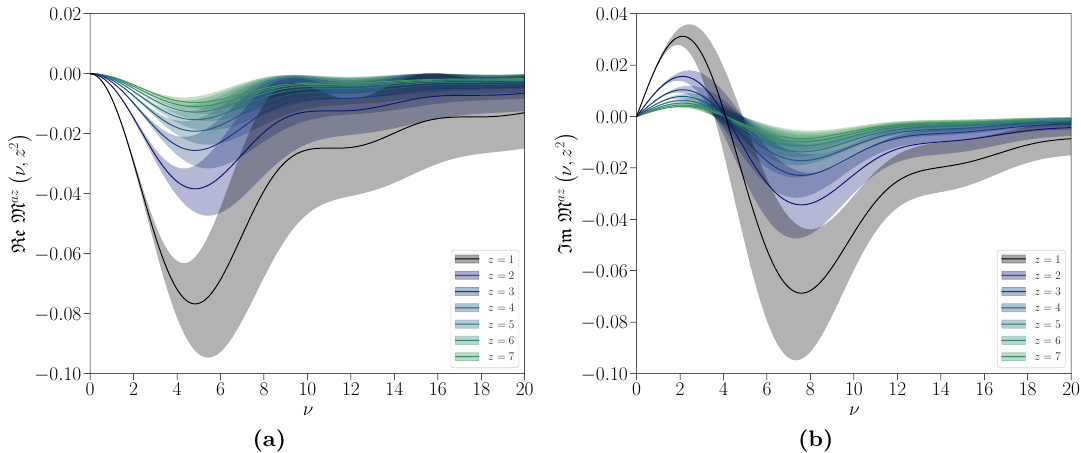
Figure 24. Visualization of the discretization effects determined by the optimal Jacobi polynomial fits { n = { 4 , 1 , 3 , 2 } and { n = { 3 , 3 , 1 , 0 } for z/a ≤ 7 . lt , n az , n t 4 , n t 6 } v v (a) lt , n az , n t 4 , n t 6 } + + (b)